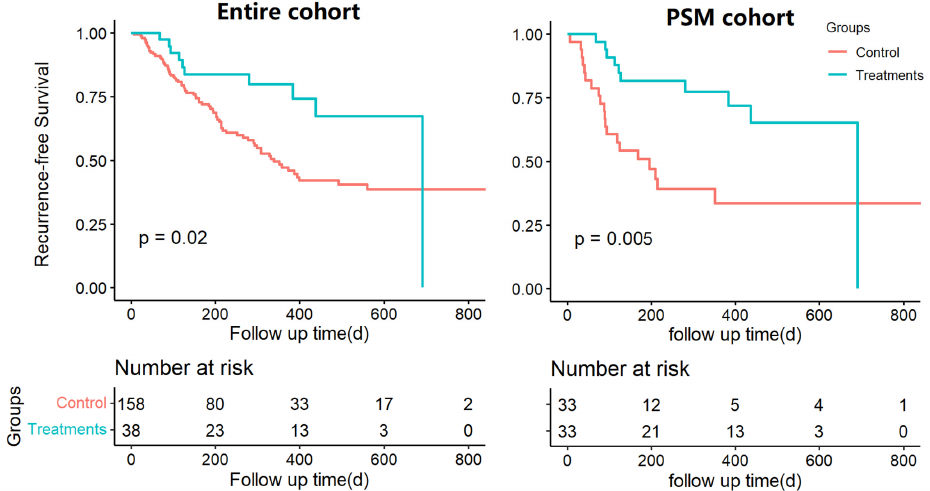
Figure 2. Comparison of recurrence-free survival curve between control and treatment group for HCC recurrence in the entire cohort and propensity score-matched (PSM) cohort.